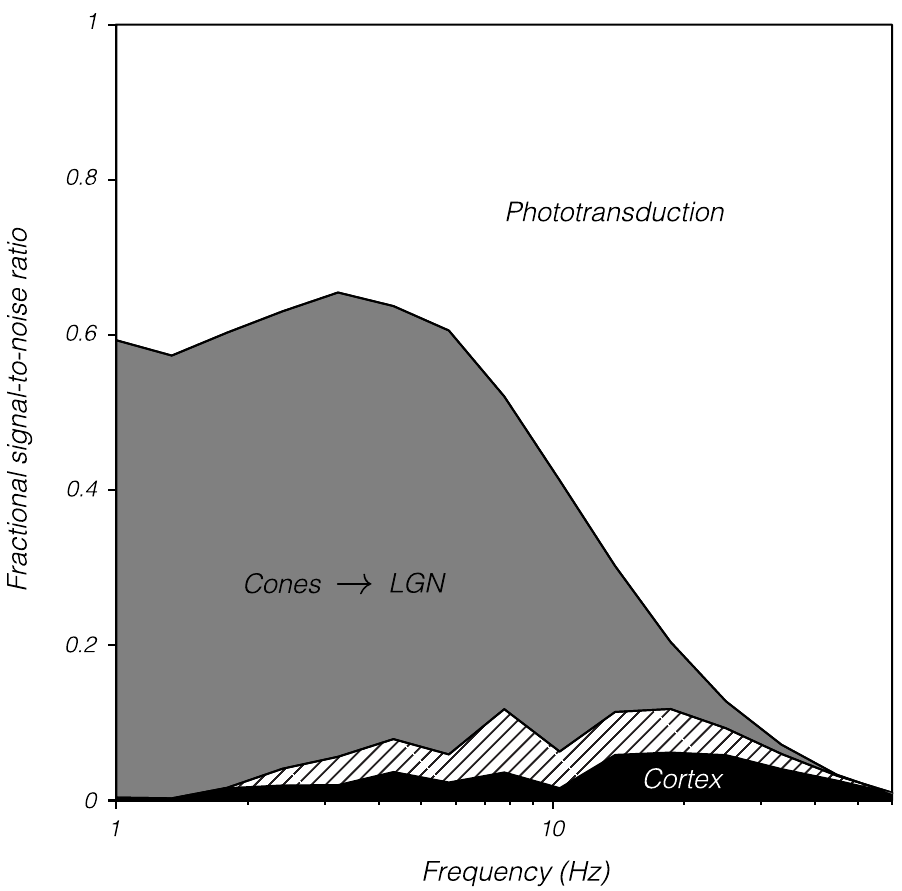
Fig 9. Fractional signal-to-noise ratio as a function of temporal frequency and stage of the visual system. Data are identical to those shown in Fig 5 but have been shifted and scaled so that d 0 of the photon absorption ideal observer is 1 and behavioral d 0 is 0. Filled-in regions represent signal-to-noise loss between pairs of consecutive stages: from photon absorption to cone currents (white), from cone currents to LGN spikes (gray), and from LGN spikes to behavior (black). Data were averaged across monkeys and across magnocellular and parvocellular populations. Parvocellular neurons were omitted below 1.5 Hz because including them reduced the d 0 of LGN populations below the theoretical floor of 1.27. Eliminating parvocellular neurons entirely increased d 0 of LGN populations across temporal frequencies (cross-hatched area). Data are available at https://github.com/horwitzlab/LGN-temporal-contrast-sensitivity/blob/ master/DataByFigure.xlsx. LGN, lateral geniculate